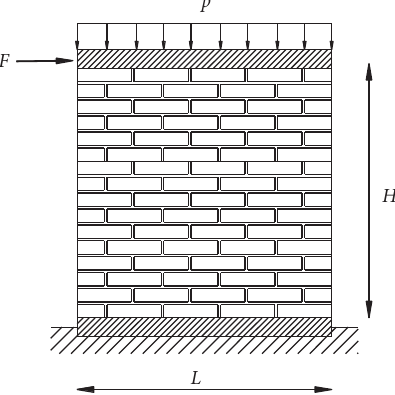
Figure 4: Masonry panel considered for the numerical tests